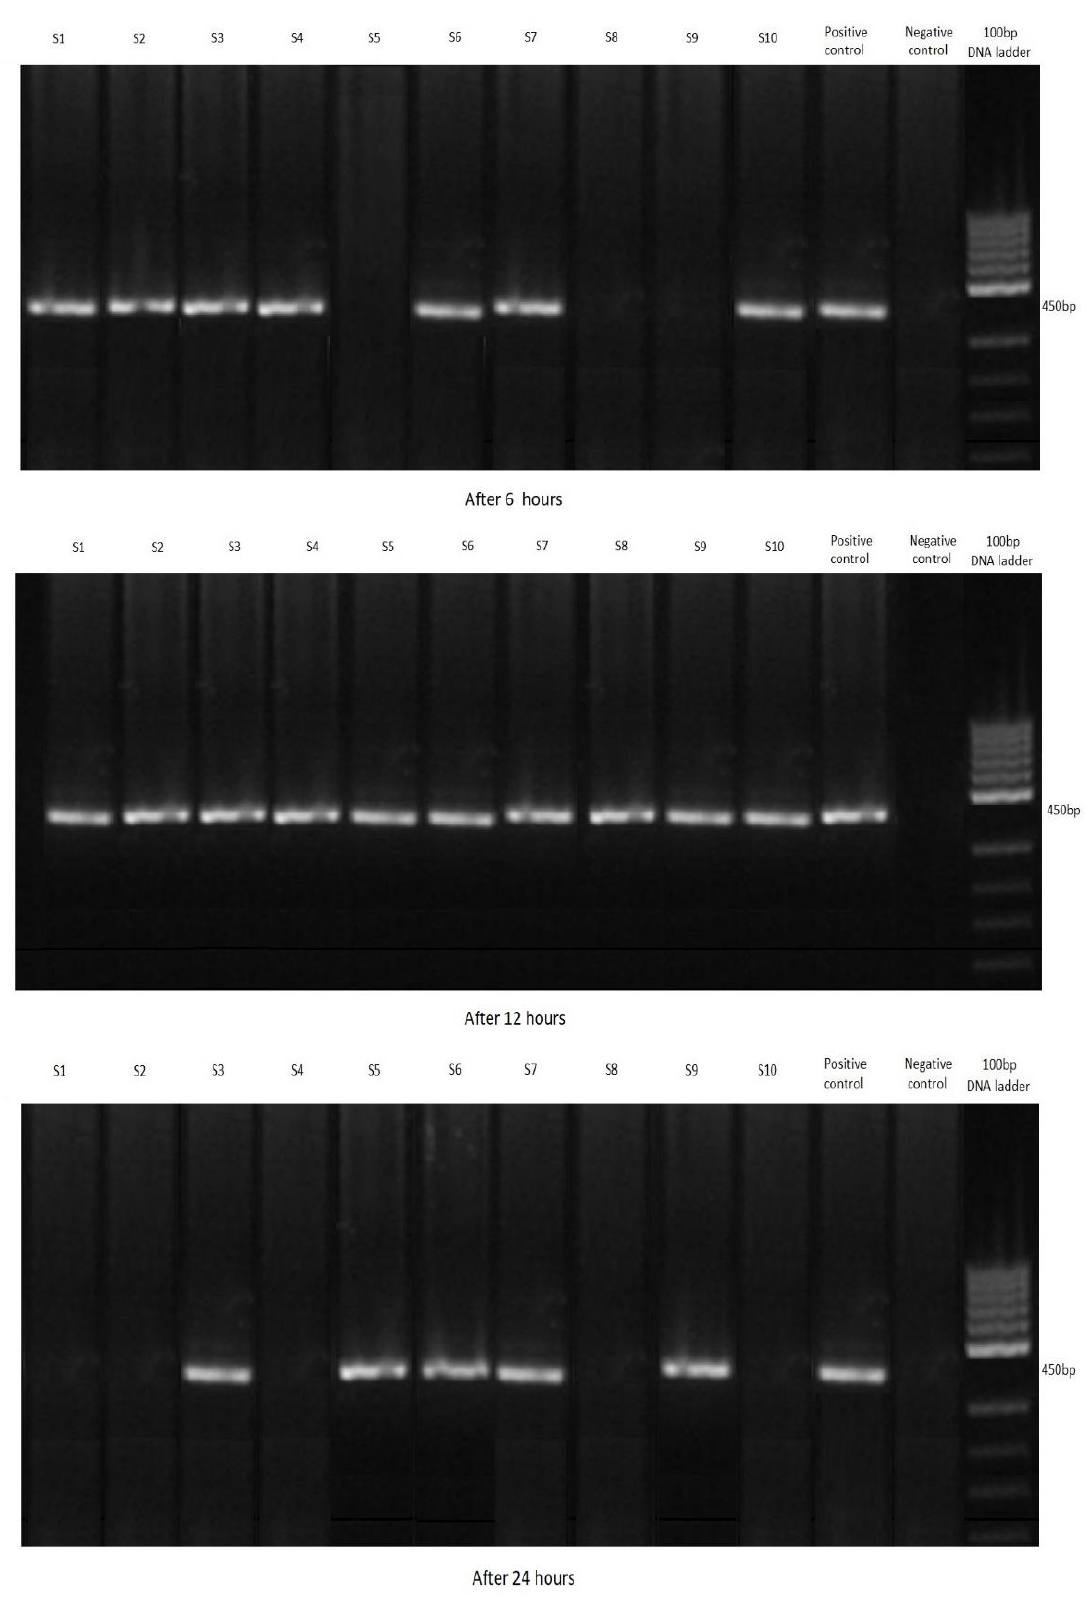
Figure 3. Agarose gel: investigated positivity of water samples for Cryptosporidium parvum with Neocaridina davidi, Group B.